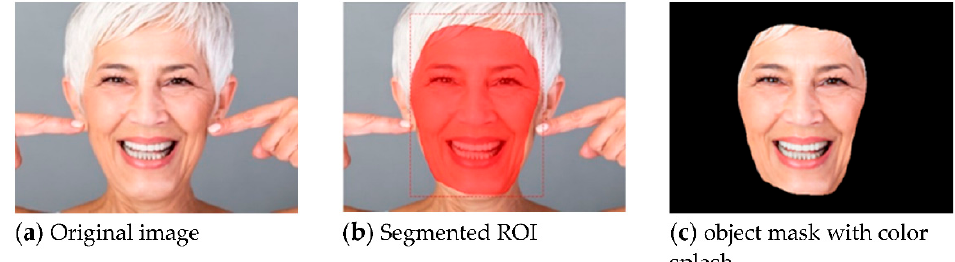
Figure 5. The results of face detection using Mask R-CNN.